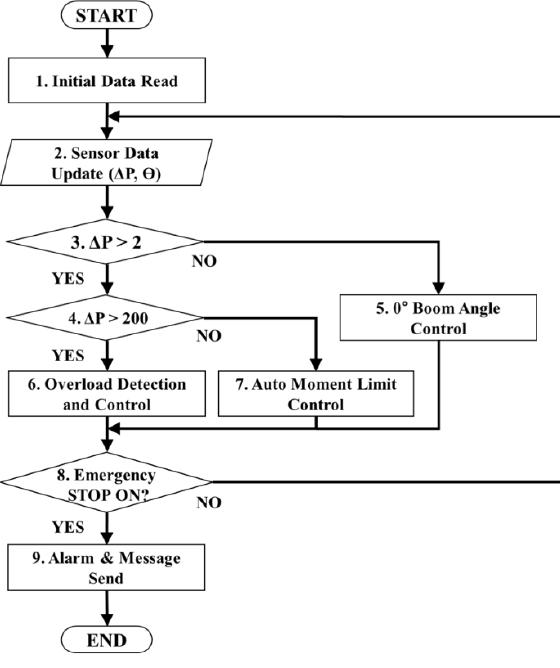
Figure 6. eAML control algorithm.